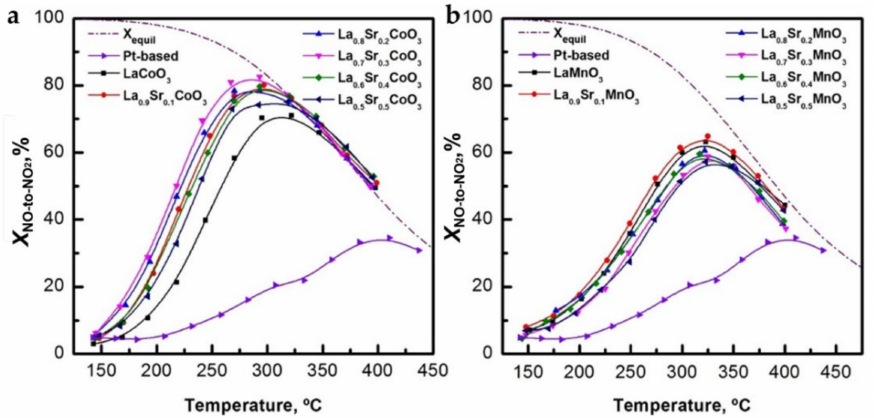
Figure 1. NO-to-NO 2 conversions over ( a ) La 1 − x Sr x CoO 3 and ( b ) La 1 − x Sr x MnO 3 perovskites with x ranging from 0 to 0.5, with model Pt-based catalyst as the benchmark. Adapted with permission from [61]. Copyright 2017,